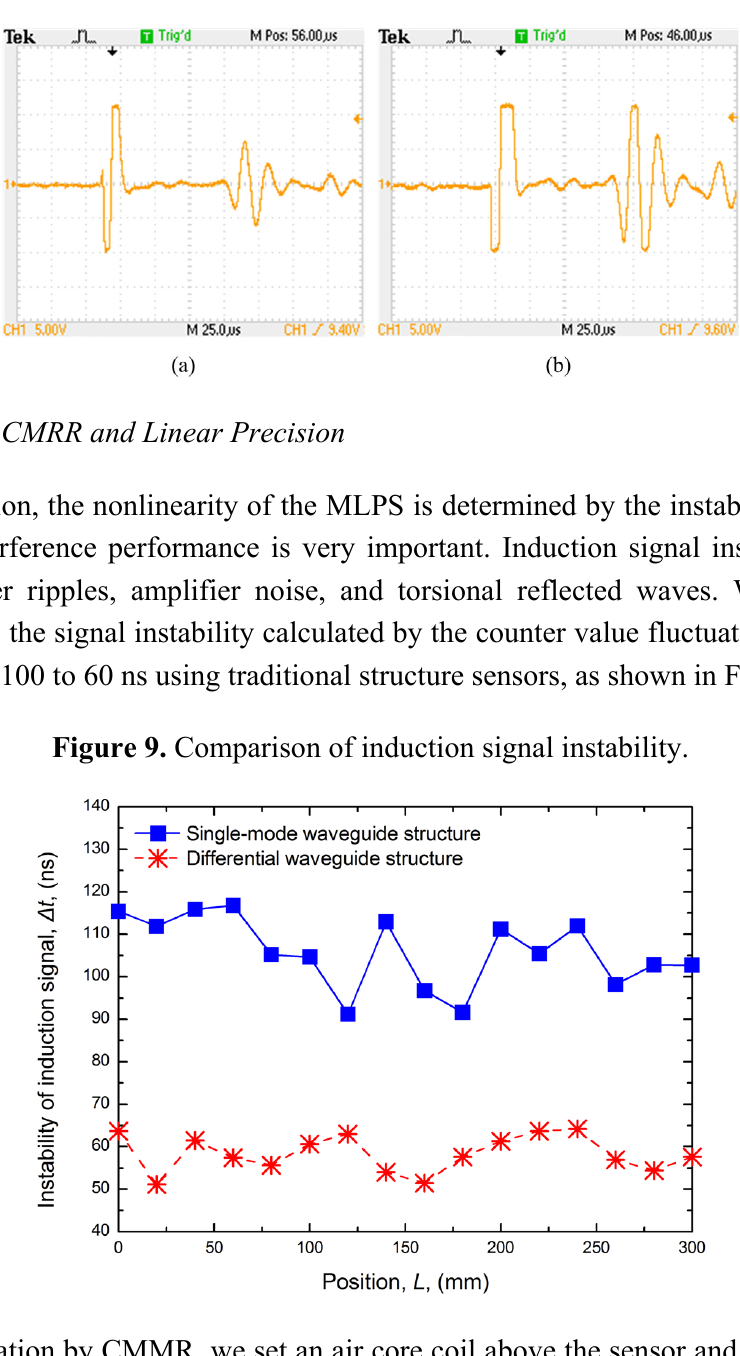
Figure 8. Waveforms of induction signal (a) with the single-mode waveguide structure; (b) with the differential waveguide structure.